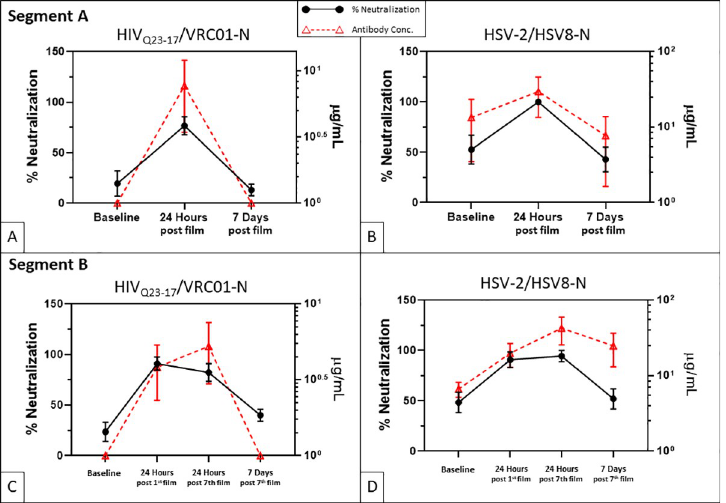
Fig 5. Viral neutralization and antibody pharmacokinetics (represented by means ± SEMs) in CVLs in Segments A and B (Active film group only). Neutralization percent is represented by solid lines/circles ( ) (left y axis), and antibody concentration is represented by dashed lines/open triangles ( ) (right y axis) in each graph. ( A). VRC01-N concentration and HIV Q23-17 neutralization in Segment A were significantly increased at 24 hours post single film insertion compared to both Baseline ( p = 0.006 and 0.01, respectively) and 7 days post single film insertion ( p = 0.006 and 0.02, respectively). ( B). HSV8-N concentrations in Segment A were significantly increased at 24 hours post single film insertion compared to both Baseline ( p = 0.04) and 7 days post single film insertion ( p = 0.01). All CVL samples from 24 hours post film insertion exhibited 100% HSV neutralization; however, the omnibus F test p -value did not reach statistical significance ( p = 0.052). ( C). VRC01-N concentration and HIV Q23-17 neutralization in Segment B were significantly elevated 24 hours after first film and 24 hours after seventh film compared to Baseline ( p < 0.001